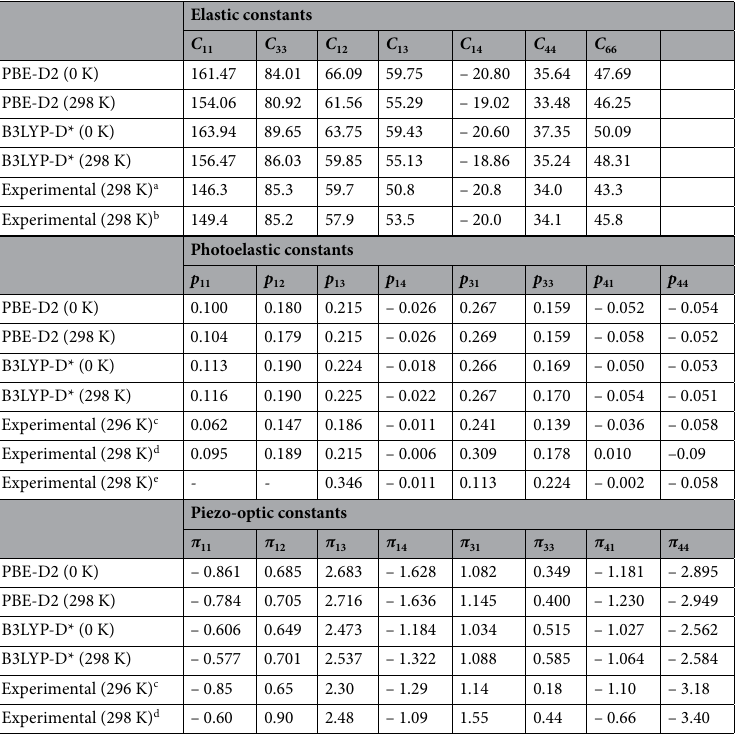
Table 2. Calcite elastic ( C vu , GPa), photoelastic ( p vu , dimensionless) and piezo-optic ( π vu , TPa –1 ) components of the corresponding fourth-rank tensors, expressed in Voigt’s notation. a 26 , b27 , c10 , d9 , e11 , calculated using results from Nelson et al. 10